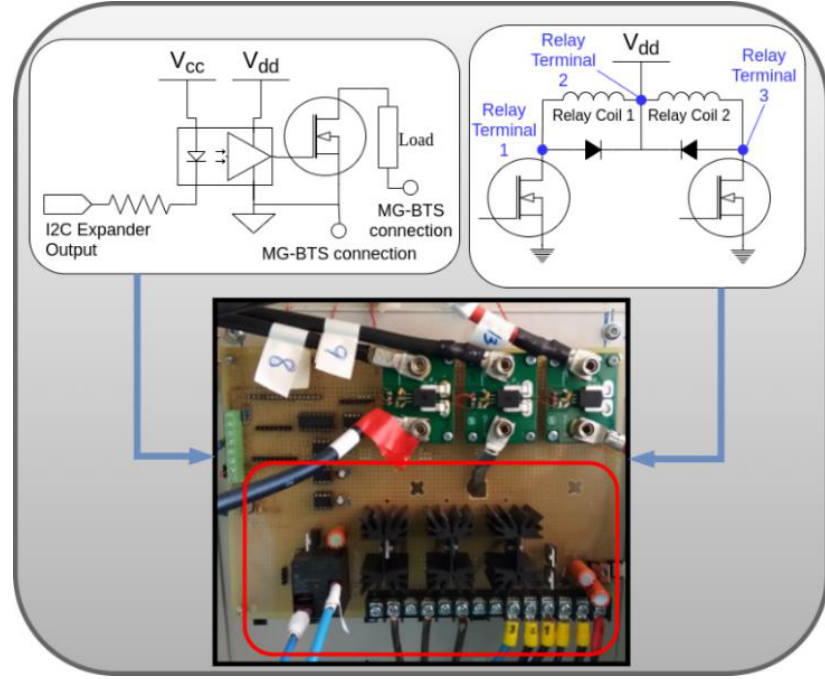
Figure 5. Conditioning circuits of the transistors and relays (SBC driver).